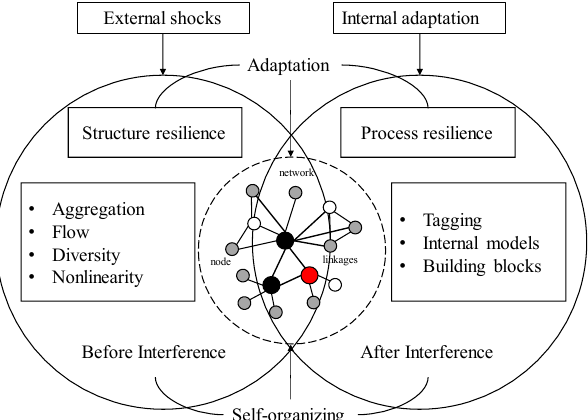
Figure 1. Conceptual framework for regional network resilience based on CAS.